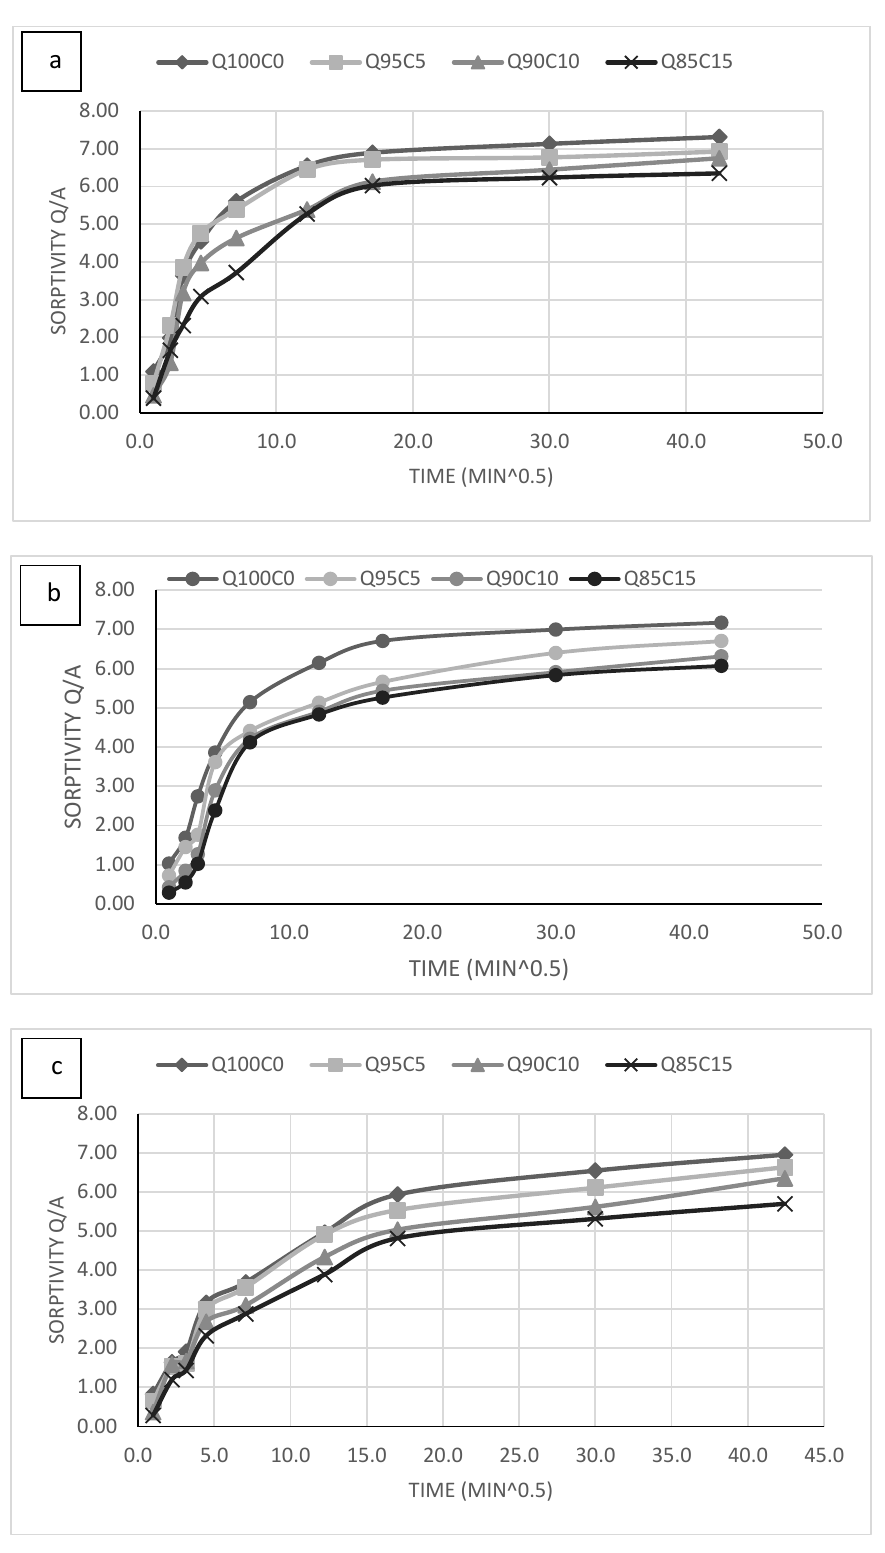
Fig. 8. Effect of OPC replacement and NaOH concentration variation on compressive strength of quartz stone powder- based mortar. a) 10M, b) 12M, c)